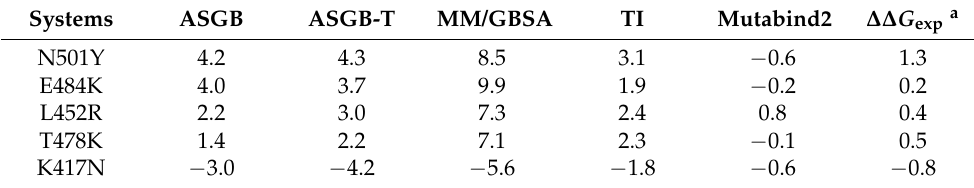
Table 3. Calculated binding energy differences between specific mutations and the wild-type SARS- CoV-2 S protein in binding to ACE2 using different methods.